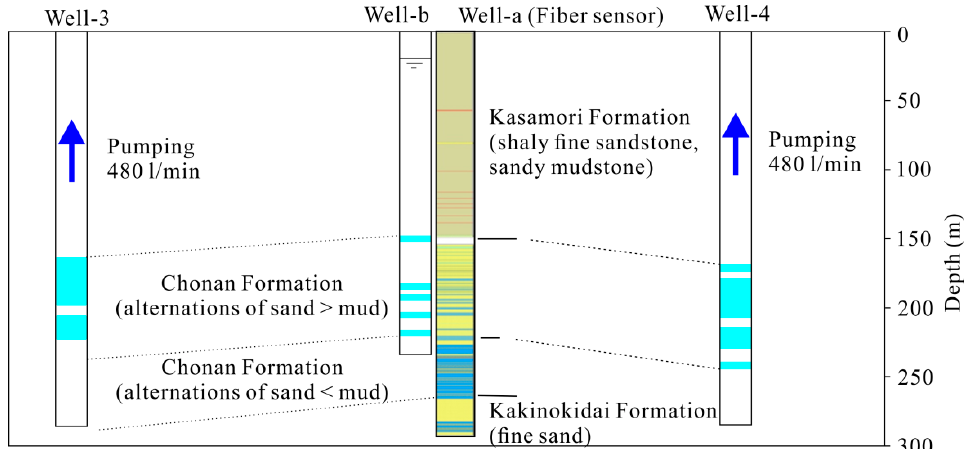
Figure 3. Profile showing well locations and simplified geological columnar